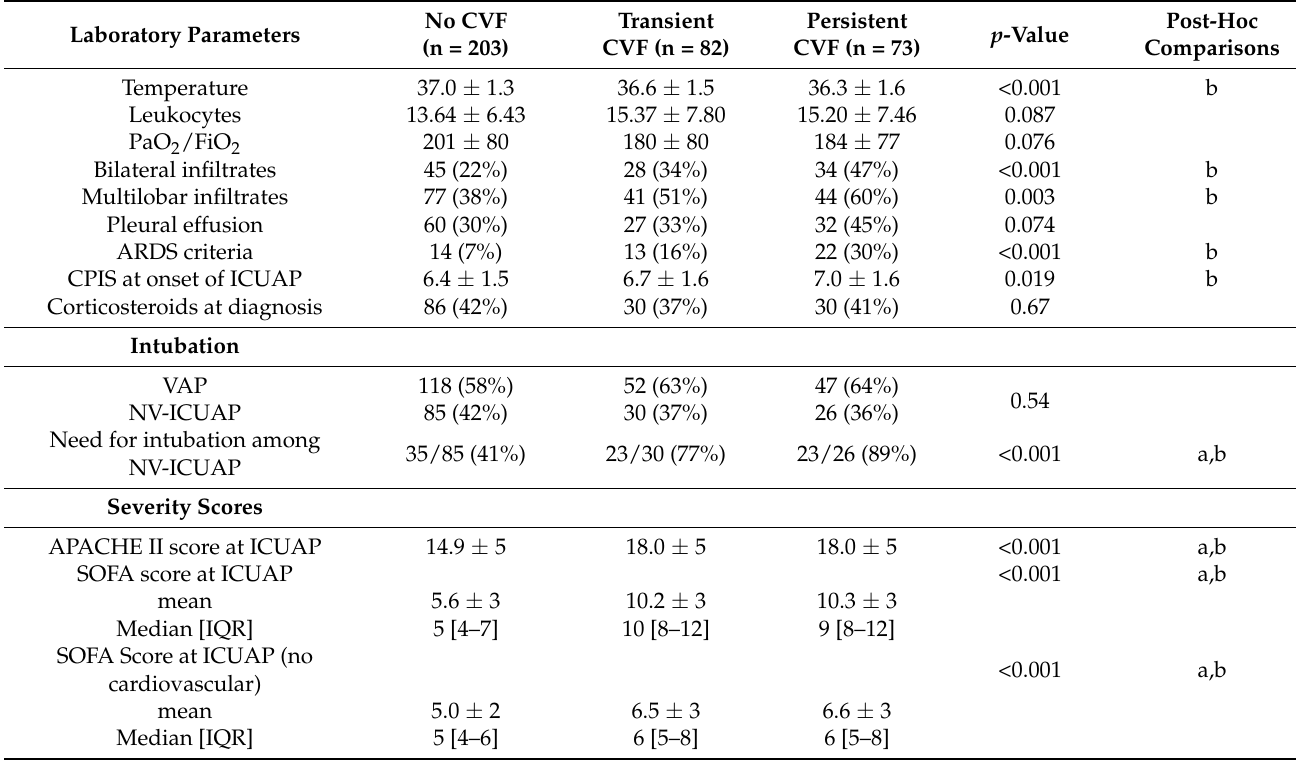
Table 2. Clinical conditions on diagnosis of